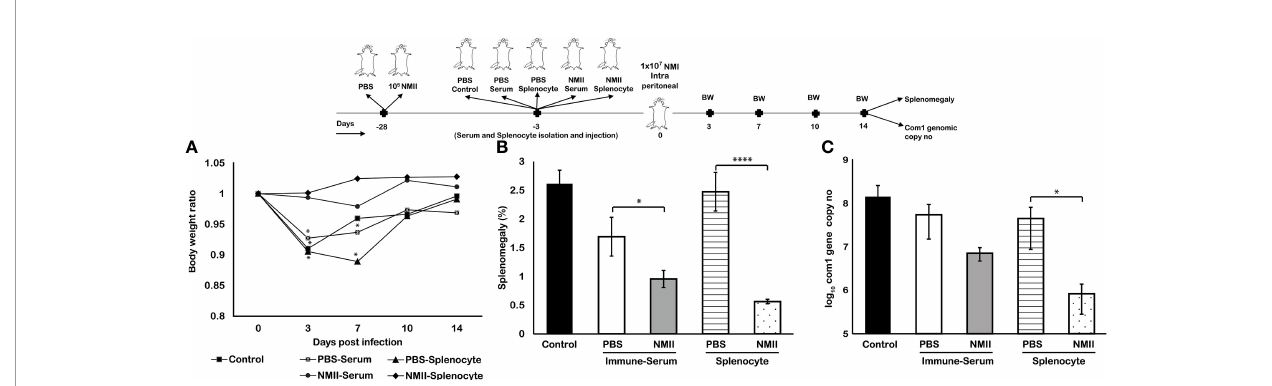
FIGURE 9 | Adoptive transfer of serum and splenocytes from NMII-immunized mice induces protection against NMI challenge in naïve mice. BALB/c mice were IP transferred with sera or splenocytes from PBS or viable NMII-immunized mice and IP challenged with 1 × 10 7 GE of NMI at 3 days post adoptive transfer. Body weight ratio (A) , splenomegaly [ (B) , % of spleen weight/body weight], and bacterial burden (log 10 C. burnetii com1 gene copy numbers) in the spleen (C) were evaluated at 14 dpi. Each experimental group includes four mice, with error bars representing the standard deviations from the means. *p < 0.05; ****p < 0.0001, as determined by Welch t test using